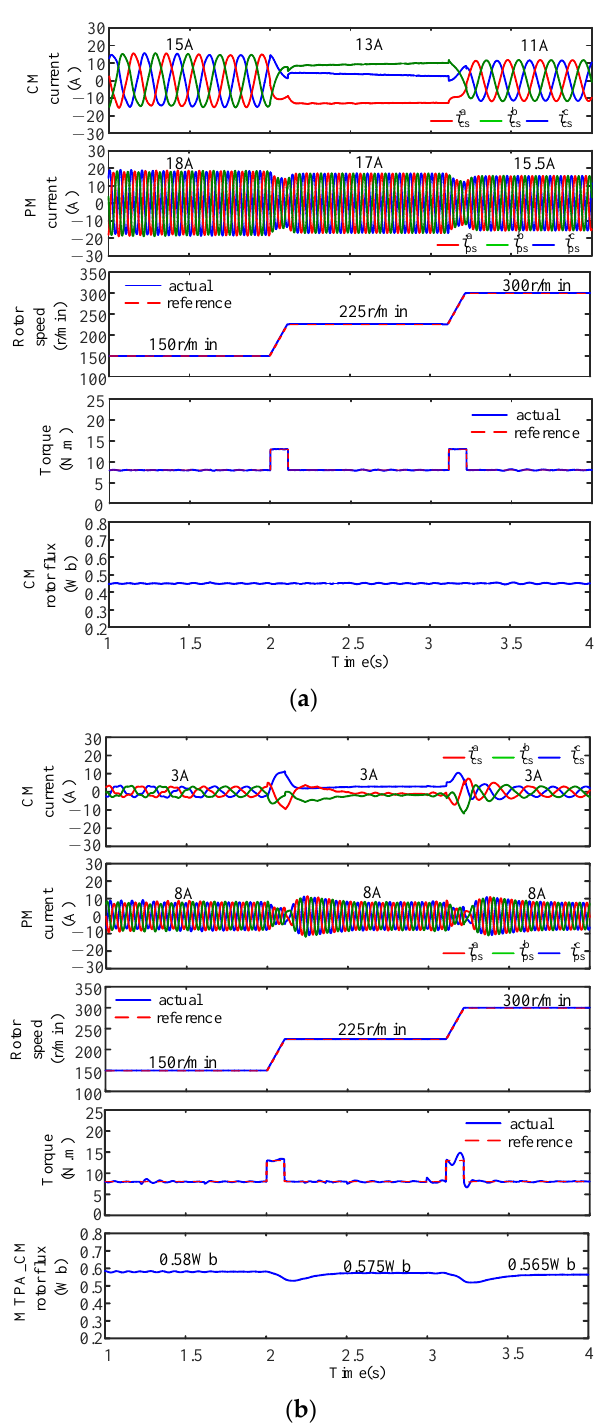
Figure 7. Simulation experiment results when the speed changes. ( a ) SFV-FLC control method; ( b ) MTPA-(SFV-FLC) control method.